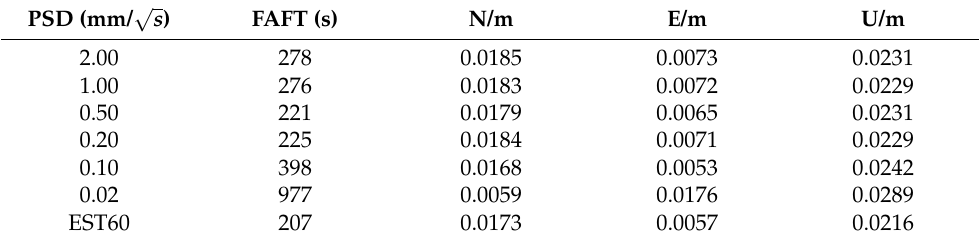
Table 4. The FAFT and positioning accuracy of Baseline C with different empirical PSD.